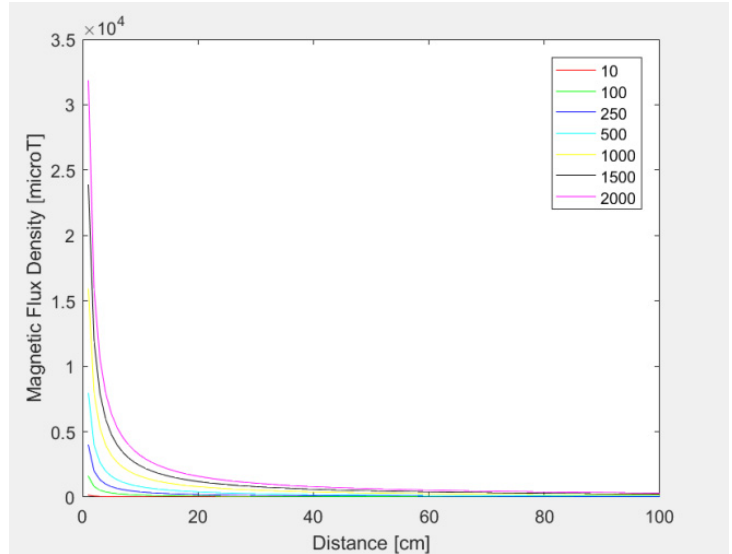
Figure 9. Magnetic field for different values of currents.